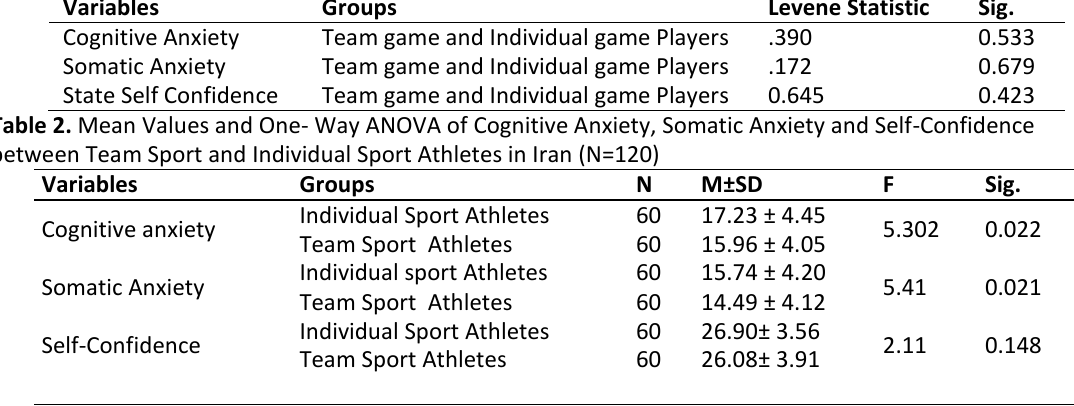
Table 1. Levene's Homogeneity Test